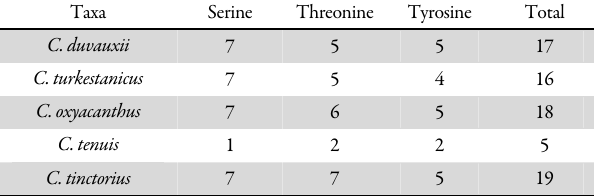
Table 3. Putative phosphorylation residue in RuBisCO protein sequences of Carthamus ssp. with a score above 0.8